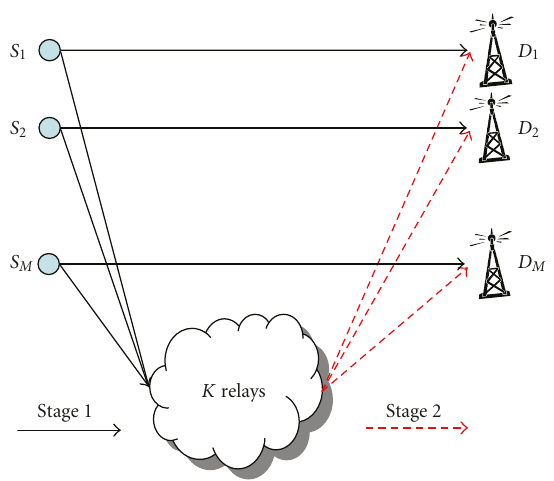
Figure 1: Cooperative transmission system